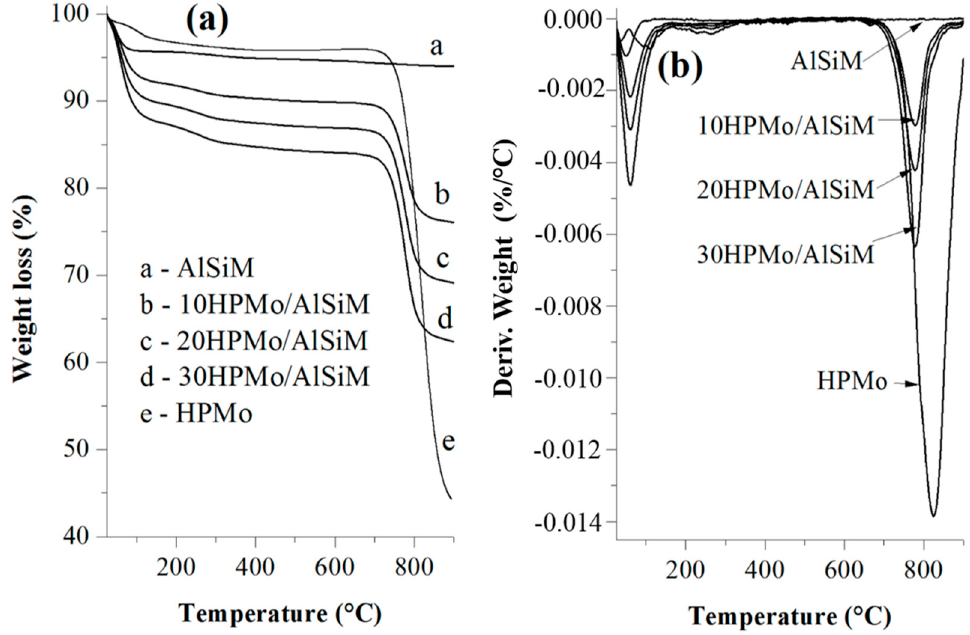
Figure 5. Thermogravimetric (TG) ( a ) and derivative thermogravimetric (DTG) ( b ) curves of the AlSiM and (10, 20, 30) HPMo / AlSiM HPMo, AlSiM and (10, 20, 30) HPMo/AlSiM samples.